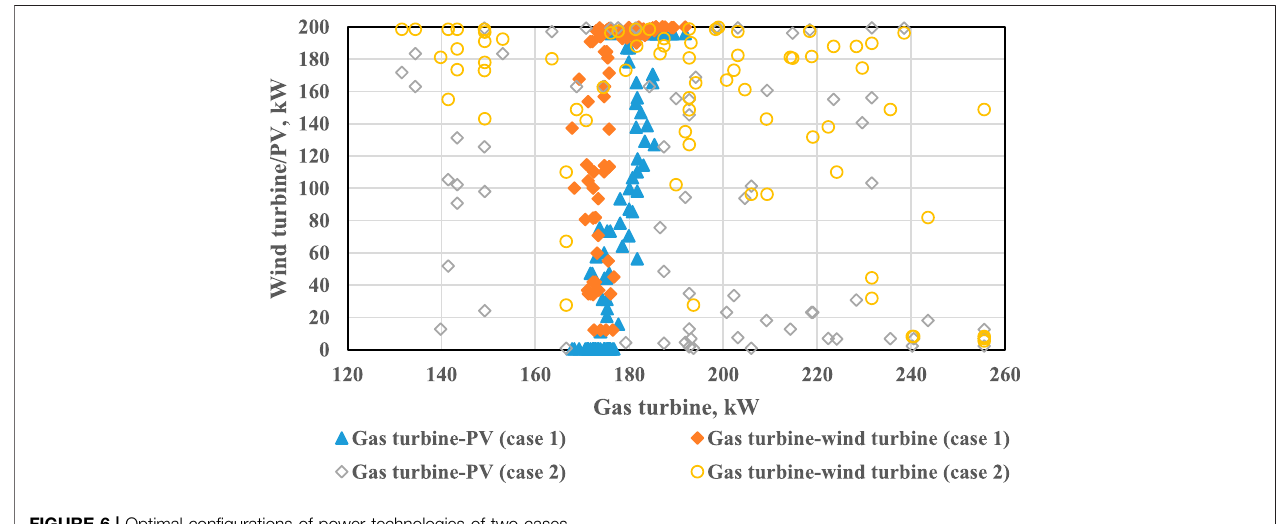
FIGURE 6 | Optimal con fi gurations of power technologies of two cases.